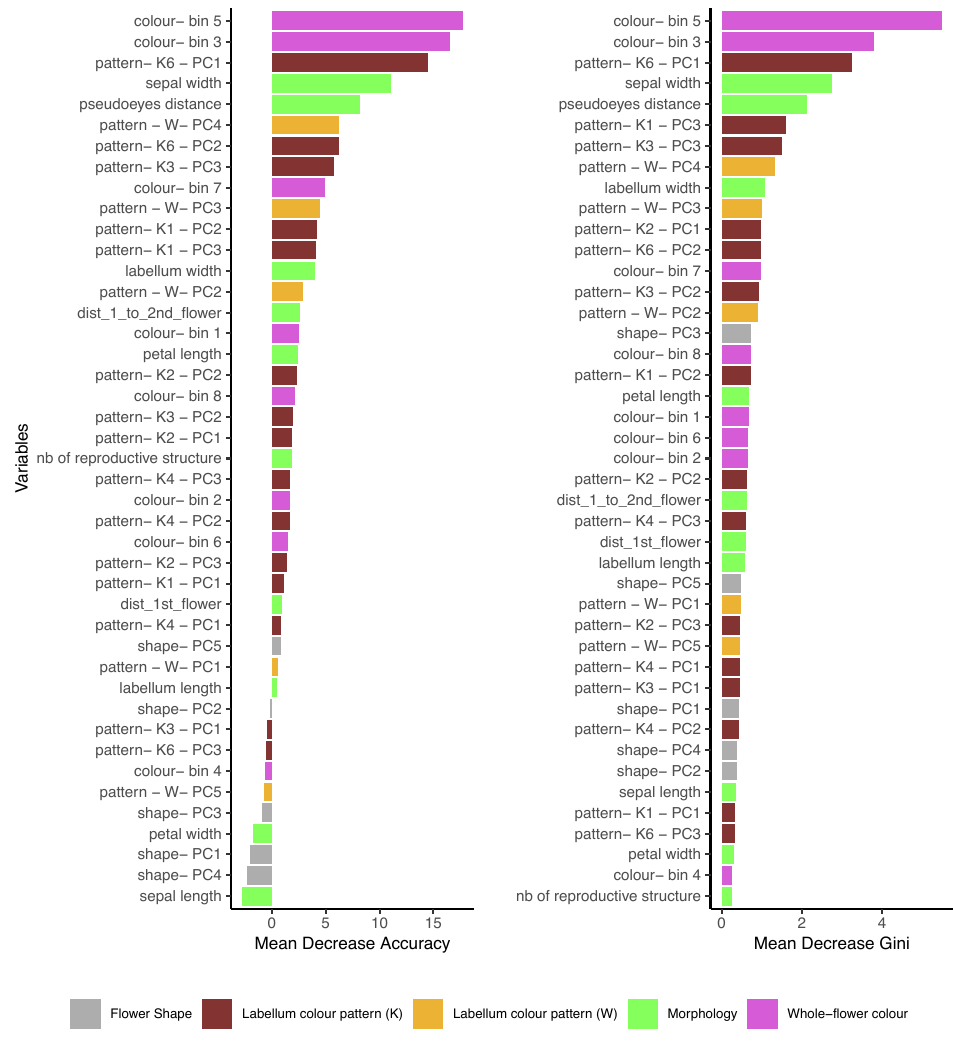
Figure 7. Variable importance defined by ( a ) mean decrease accuracy and ( b ) mean decrease gini for distinguishing between O. a. subsp. aveyronensis and O. aveyronensis subsp. vitorica based on a random forest with 1000 trees (“Combined”